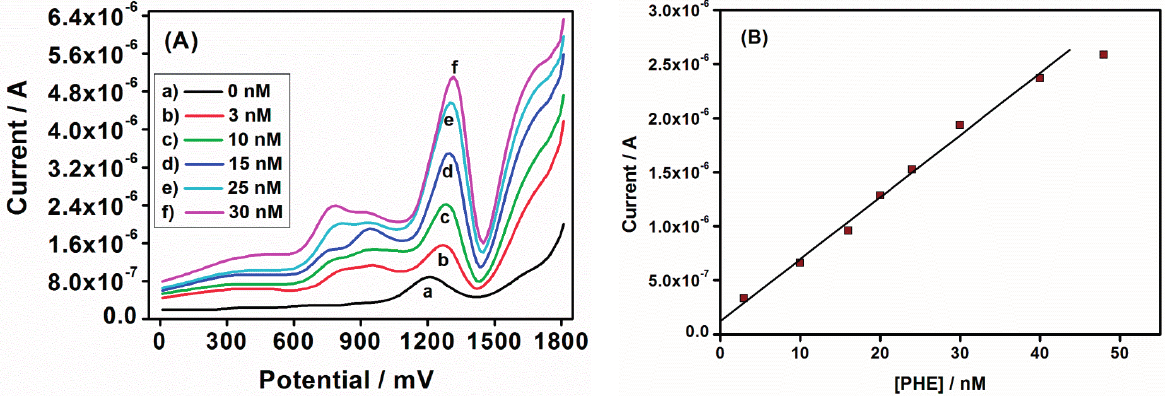
Figure 6. ( A ) CV voltammograms of the Au|G3PPT-co-P3HT in 0.1 mol/L Bu 4 NClO 4 /CH 3 CN/H 2 O with different PHE concentrations; ( B ) The calibration plot of Au|G3PPT-co-P3HT sensor for PHE.